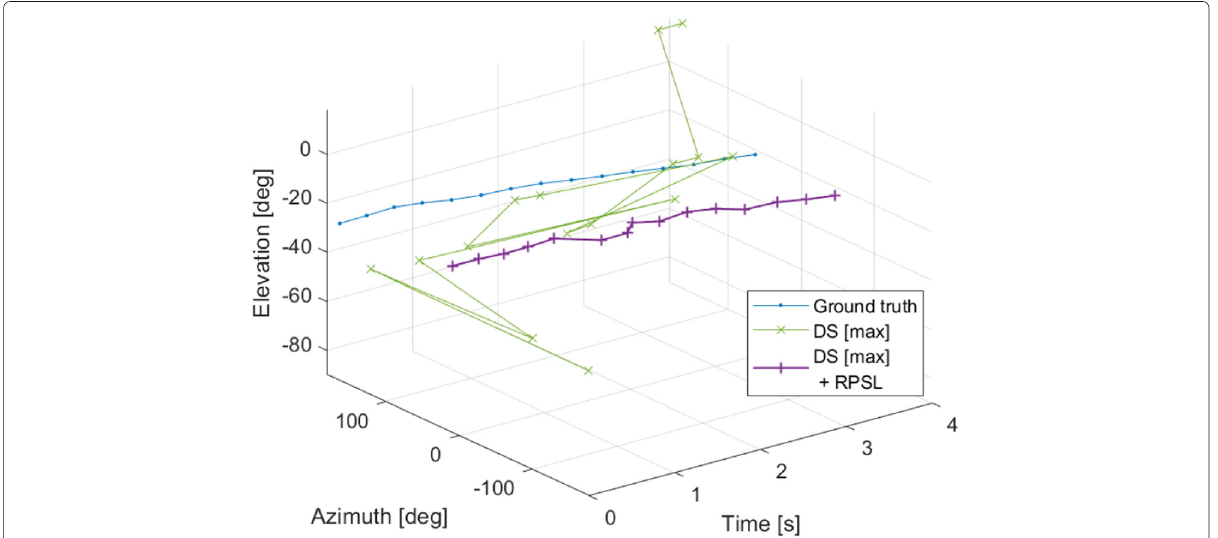
Fig. 17 Example of localisation path estimated for flying UAV speech sound source (task 3) case 10 [1], using the baseline and proposed method (RPSL only)